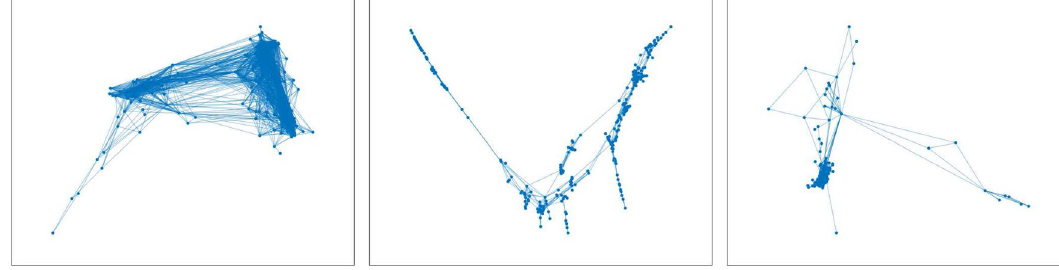
Figure 2. The network diagrams.